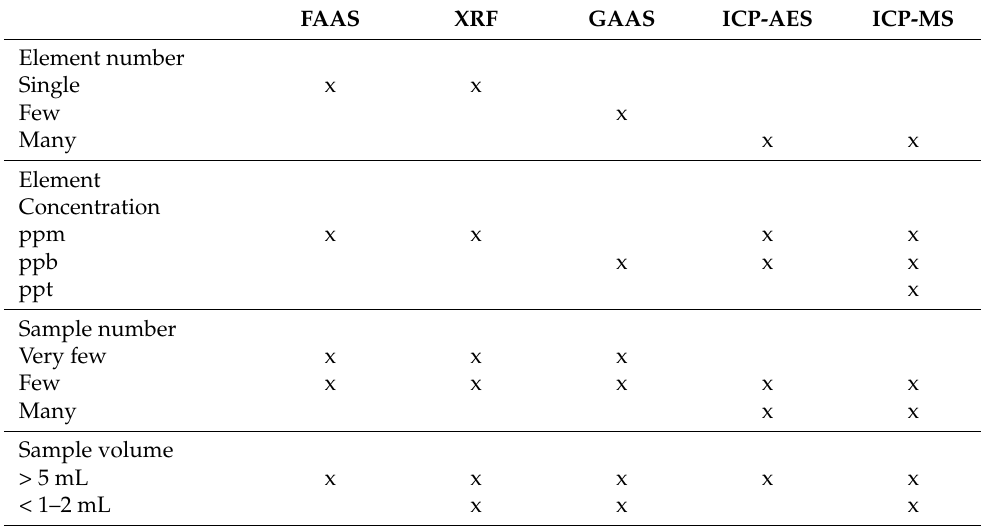
Table 2. Main criteria for the choice of the analysis method for trace element determination (adapted from [177]).